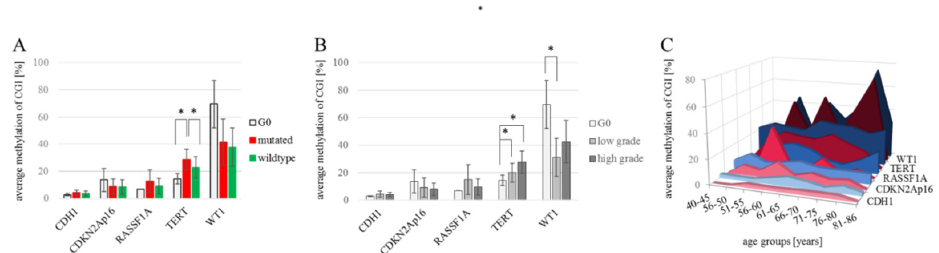
Figure 1. Developments of CDH1/CDKN2Ap16/RASSF1A/TERT/WT1 methylation levels. ( A ) Average promoter methylation levels for each gene of interest for tumor-free control samples (n CDH1 = 2;